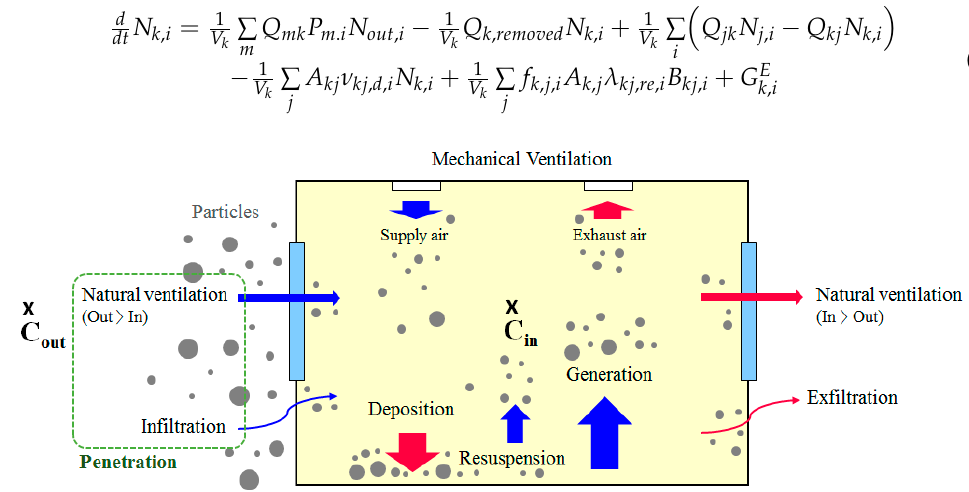
Figure 1. Mechanism of particle penetration and transport.